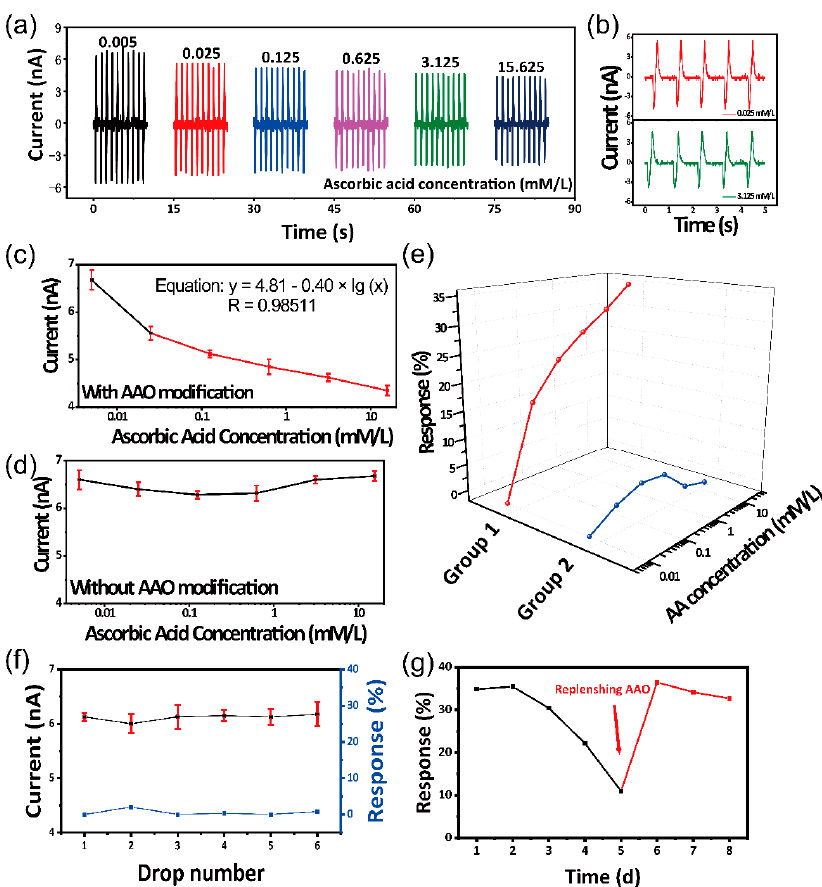
Figure 3. The AA biosensing performance of the self-powered sour sensor. ( a ) The output triboelectric current of the device against AA with the concentration from 0.005 to 15.625 mM/L. ( b ) The enlarged views of output triboelectric current at the AA concentration of 0.0025 and 3.125 mM/L, respectively. ( c ) The output triboelectric current of the device with AAO modification against AA with the concentration from 0.005 to 15.625 mM/L, respectively. Red line is the limit of detection. ( d ) The output triboelectric current of the device without AAO modification against AA with the concentration from 0.005 to 15.625 mM/L, respectively. ( e ) Response of two control experiments. ( f ) The triboelectric current and response of the sour sensor by adding deionized water. ( g ) The response of the sour sensor during 8 days.